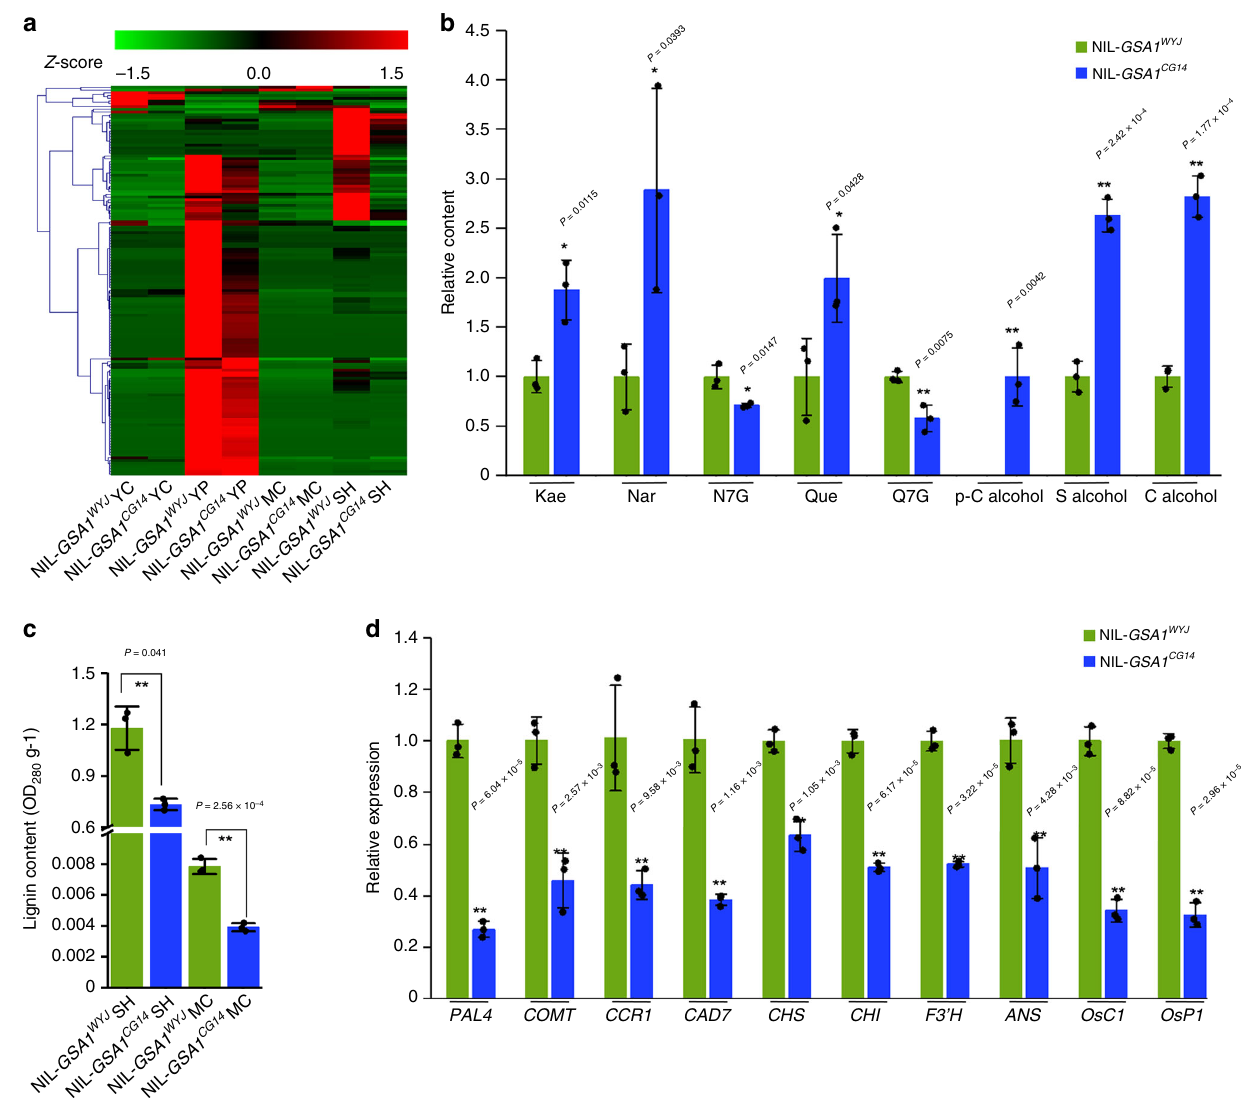
Fig. 3 Altered fl avonoid glycoside pro fi les and phenylpropanoid pathway in NIL- GSA1 CG14 . a Clustering heat maps of the relative levels of fl avonoid glycosides in young caryopses (YC, 10 days after fl owering), young panicles (YP, ~10 cm) at the booting stage, mature caryopses (MC) and mature spikelet hulls (SH) of NIL- GSA1 WYJ and NIL- GSA1 CG14 ( n = 3 biological replicates) from widely targeted metabolomics data. Standard-scores (Z-scores) were used as the numerical signs to evaluate the standard deviations from the mean of the corresponding samples. b Relative levels of fl avonoids and fl avonoid glycosides (Kae, Nar, N7G, Que, Q7G) in young panicles and monolignol (p-C alcohol, S alcohol, C alcohol) in young caryopses of NIL- GSA1 WYJ and NIL- GSA1 CG14 ( n = 3 biological replicates). Kae, kaempferol. Nar, naringenin. N7G, naringenin-7- O -glucoside. Que, quercetin. Q7G, quercetin-7- O -glucoside.